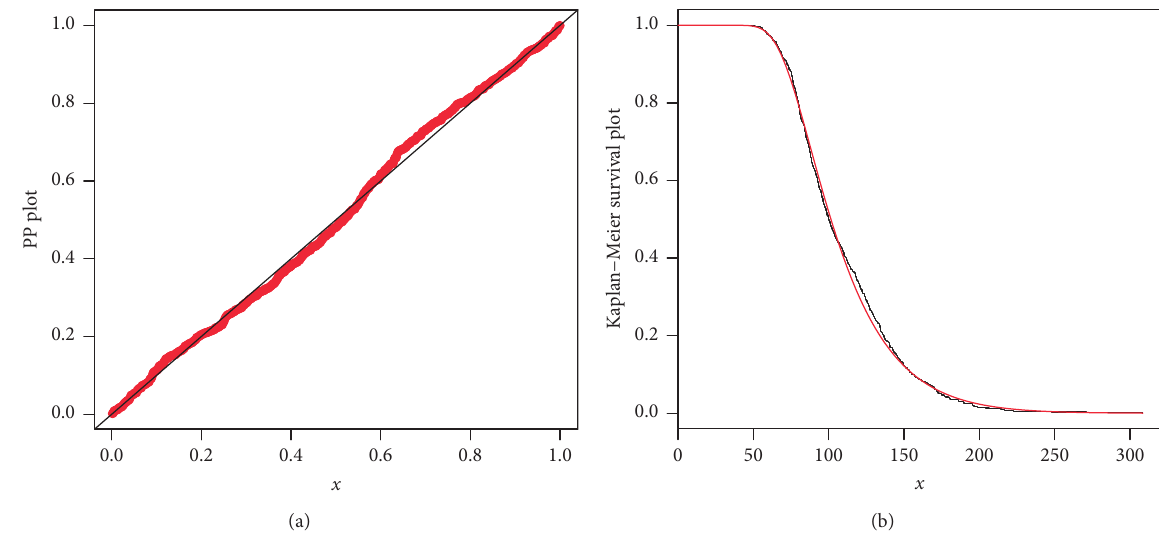
Figure 9: PP plot Kaplan–Meier survival plot of the ASE-W distribution. Table 10: Numerical results of the VaR and TVaR for the competing models for insurance claims